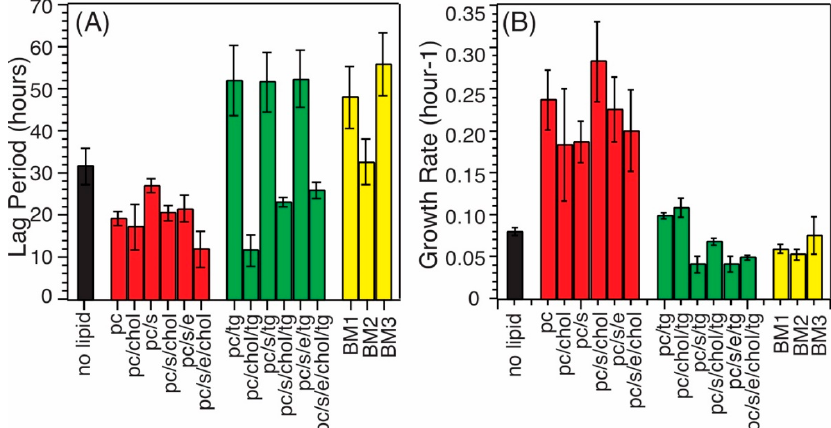
Figure 3. Plot of the lag periods (t lag , A) and growth rate constants (k, B) for A β 40 fibrillization in di ff erent membrane models. Error bars were generated from three repetitions of thioflavin-T (ThT) kinetic curves shown in Figure 2. Di ff erent colors are used to facilitate the presentation (di ff erent model